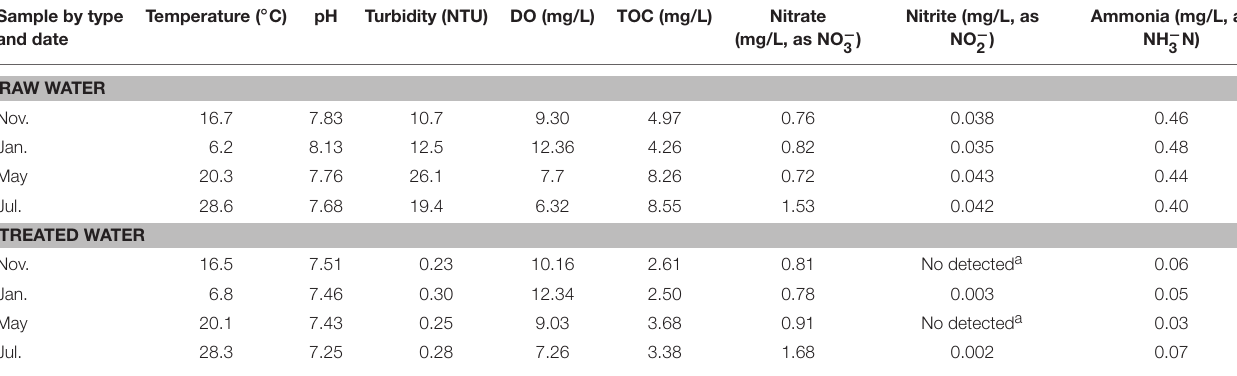
TABLE 1 | Water quality parameters of source water and treated water at each sampling time. Sample by type and